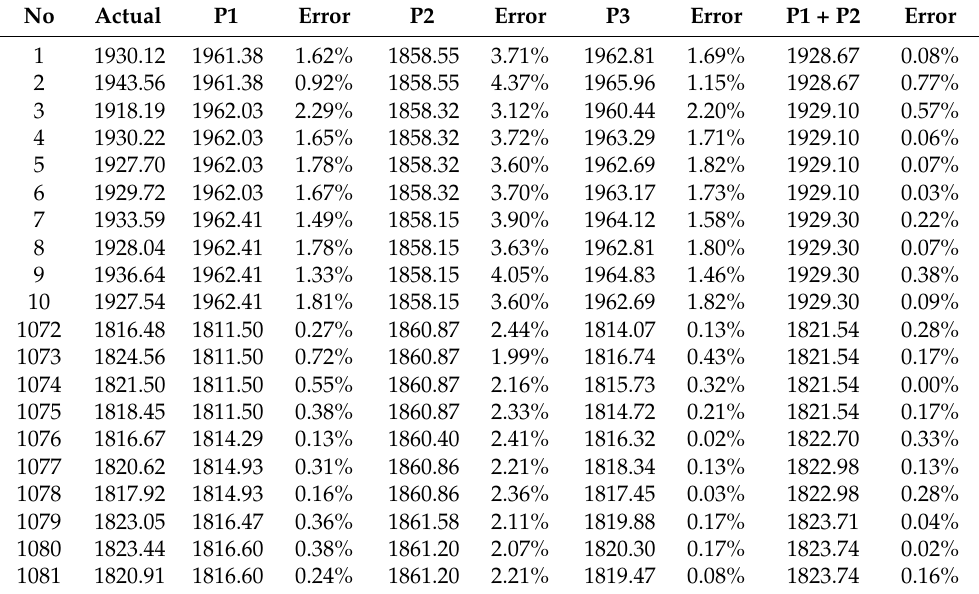
Table 3. Test data for P1, P2, P3 and P1 + P2.